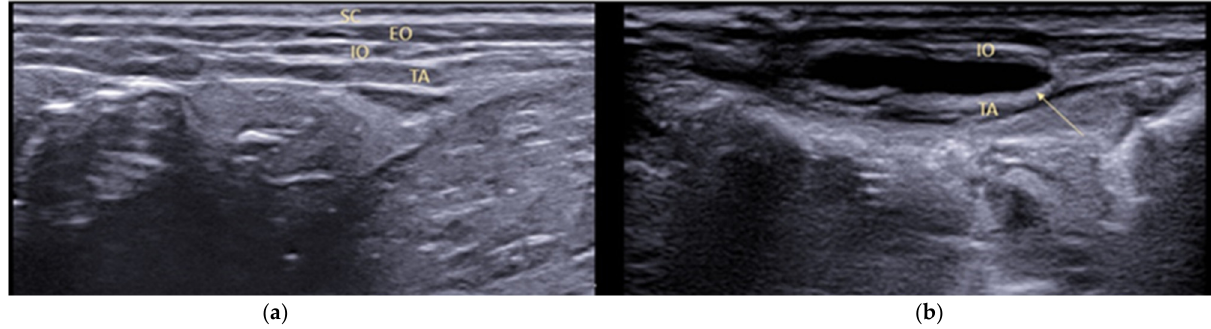
Figure 3. Ultrasonographic visualisation of the anatomical structures of the abdominal wall in a dog (SC, subcutaneous tissue; EO, obliquus externus; IO, obliquus internus; TA, transversus abdominis) before ( a ) and after ( b ) local anaesthetic injection. The patient in lateral decubitus.